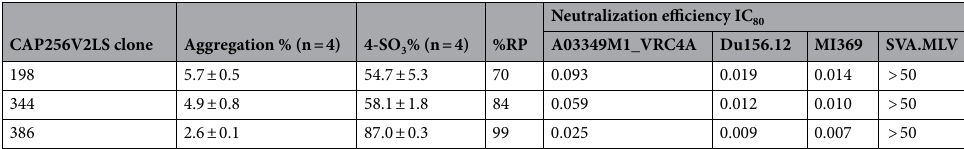
Table 1. Aggregation, %4-SO 3 levels and the corresponding in vitro potency for the top three clones. (%RP, a single value from the curve, is normalized against an interim CAP256V2LS reference standard. Neutralization efficiency IC 80 is a single value derived from interpolation of 80% signal reduction on a 10 point serially diluted point curve fit via 5-PL non-regression